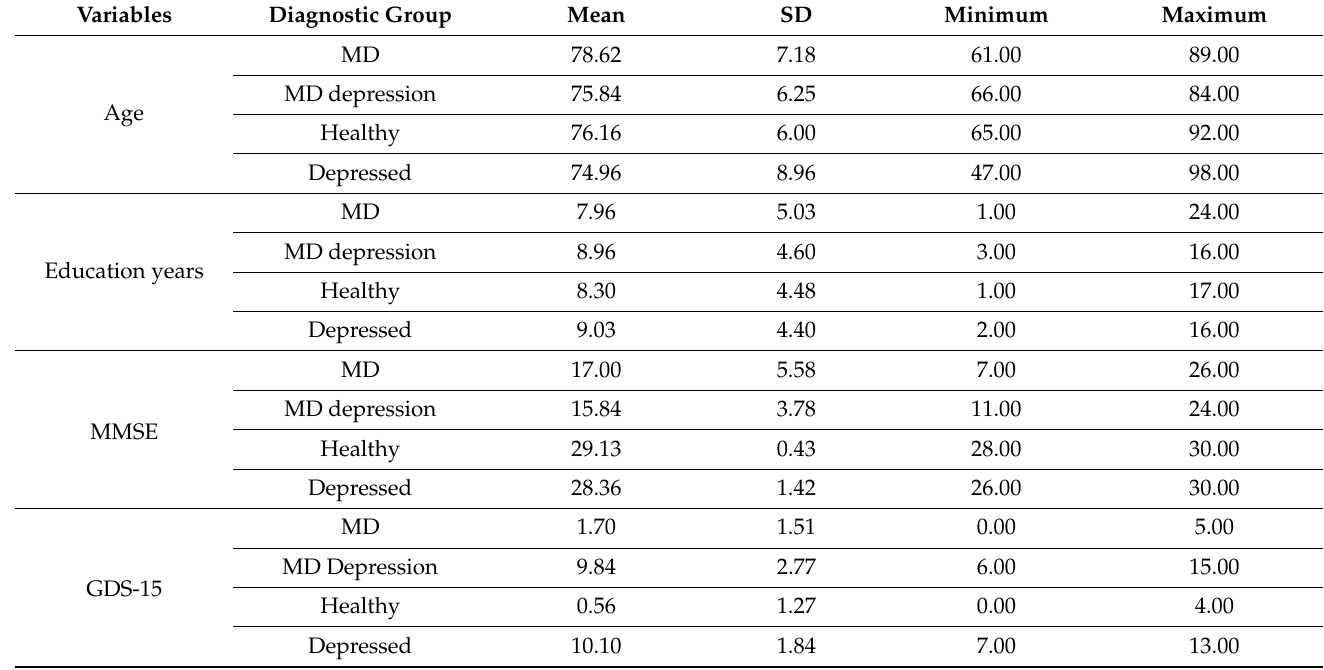
Table 1. Demographics, MMSE, GDS-15, and LCPTLAS scores for the four